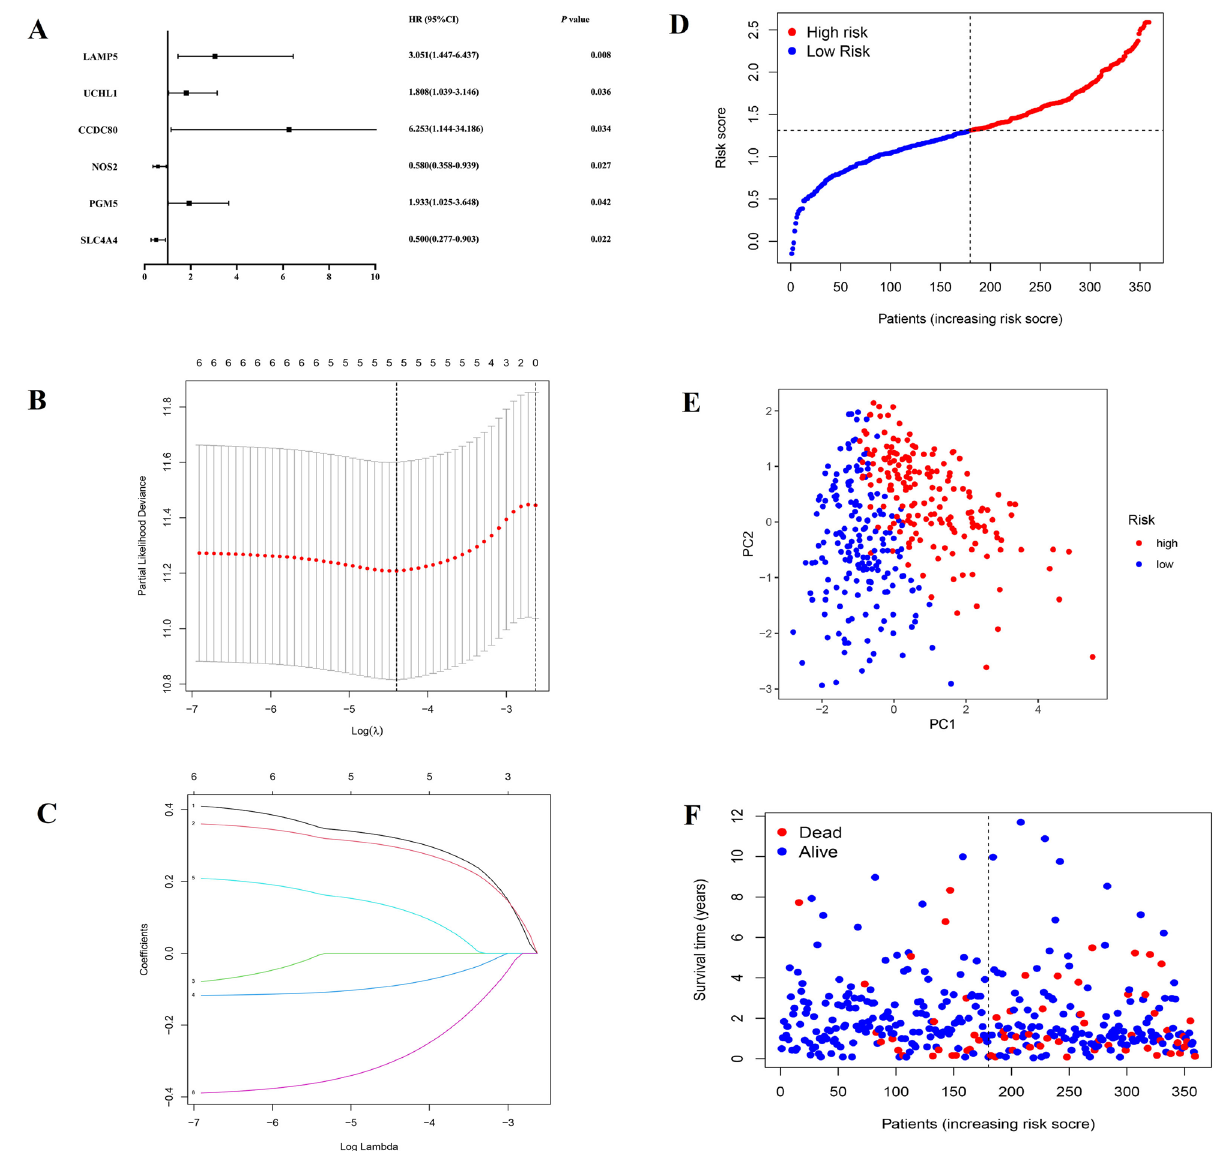
Figure 5. Establishment of prognostic gene signature based on pyroptosis-related clusters. ( A ) Multivariable COX analysis used to identify the survival-related DEGs. ( B ) and ( C ) Pyroptosis-related risk model was constructed by lasso regression. ( D )–( F ) Patients in TCGA-CC testing set were divided respectively as low- and high-risk group according to this cut-off